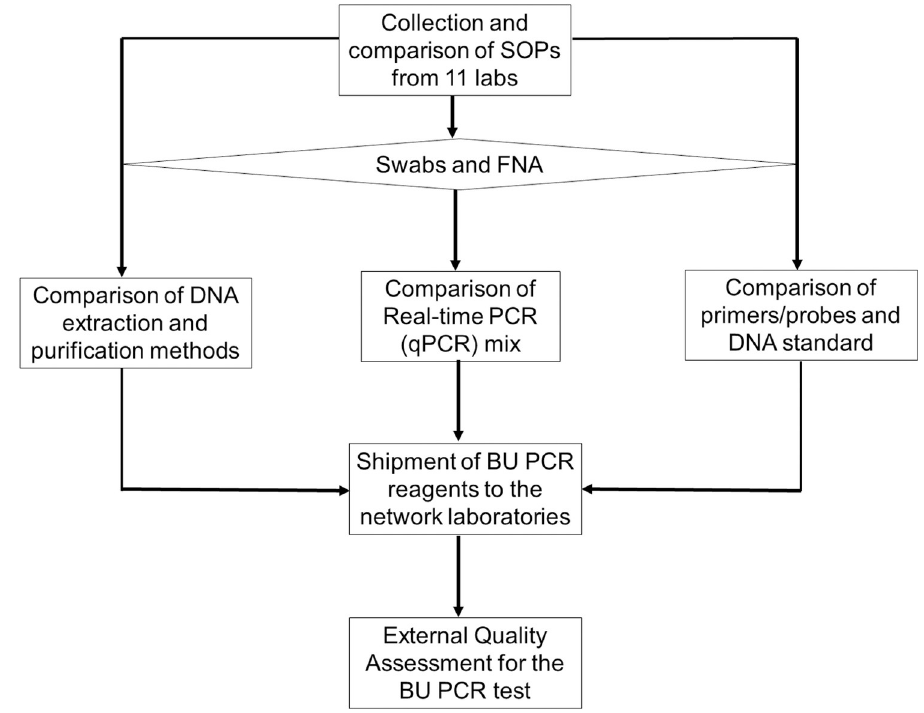
Fig 1. Flowchart of study